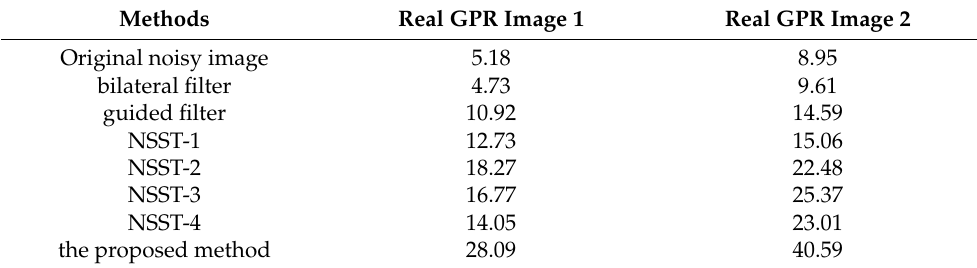
Table 4. TNR results of different denoising